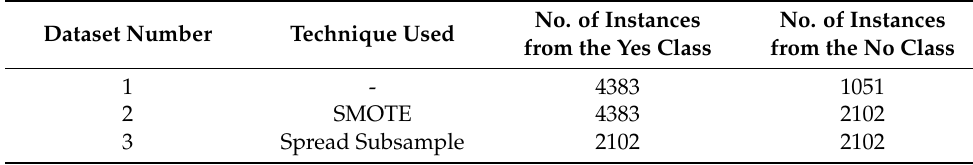
Table 3. The results of the SMOTE and Spread Subsample